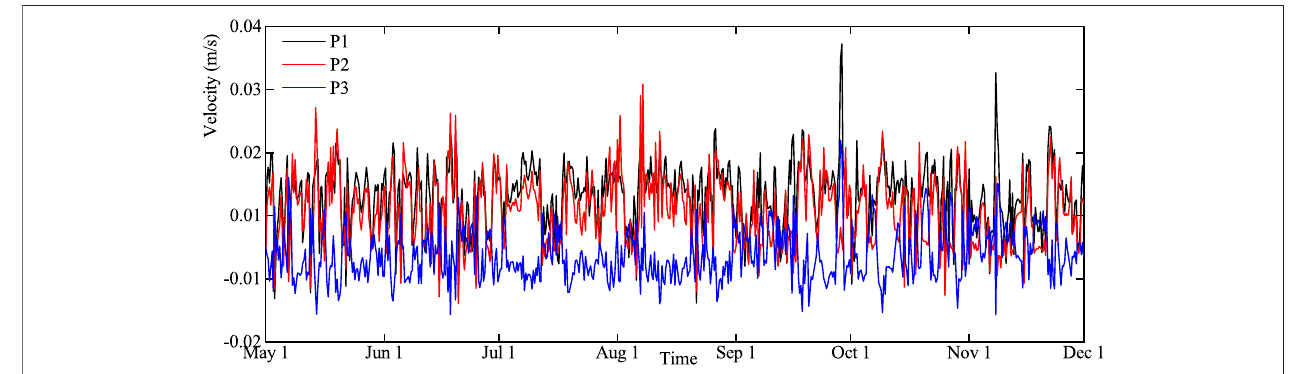
FIGURE 9 | Time variation of velocity difference at monitoring points; positive values in the fi gure indicate that the fl ow velocity under the condition of without vegetation is higher than that under the condition of with vegetation.